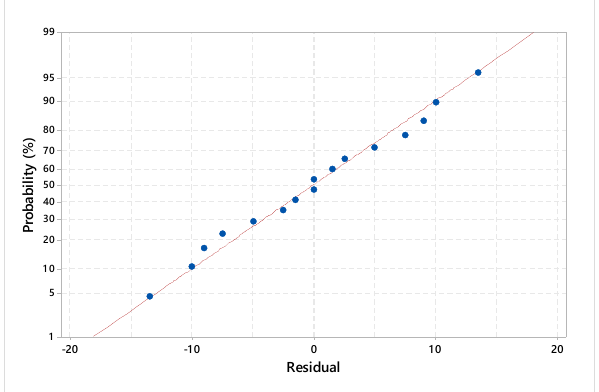
Figure 6. Normal probability plot of residuals.